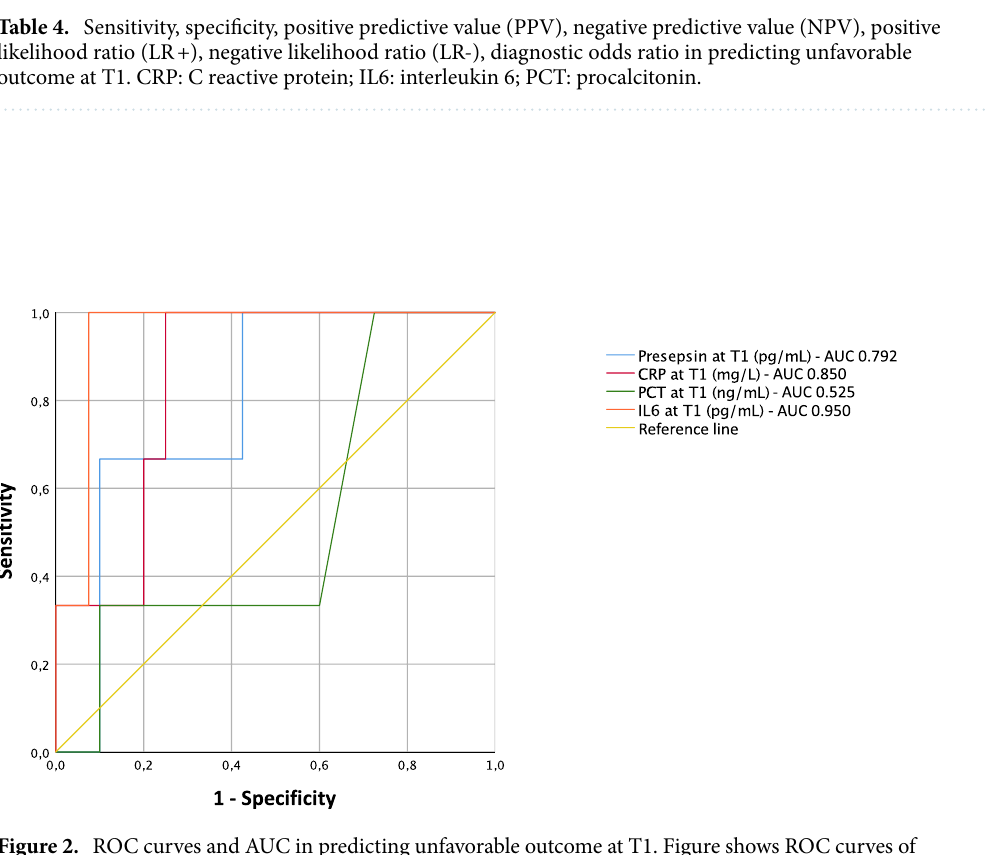
Figure 2. ROC curves and AUC in predicting unfavorable outcome at T1. Figure shows ROC curves of presepsin, CRP, PCT and IL6 in predicting unfavorable outcome of FN at